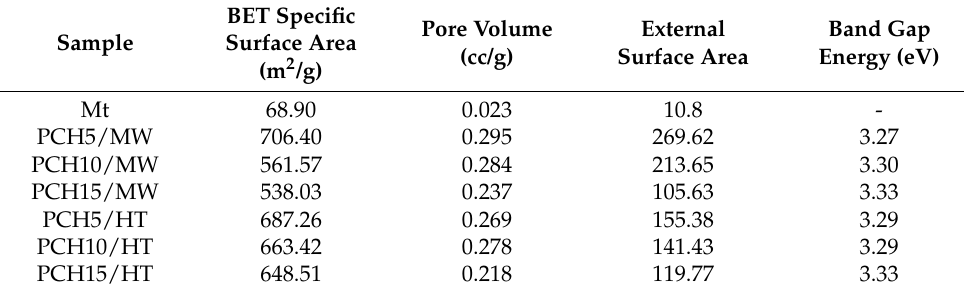
Figure 4. ( a , b ) Adsorption–desorption profile of materials; ( c ) Pore distribution of materials. Table 2. Surface parameters and band gap energy of ZnO/SiO 2 ‐ PCH samples.